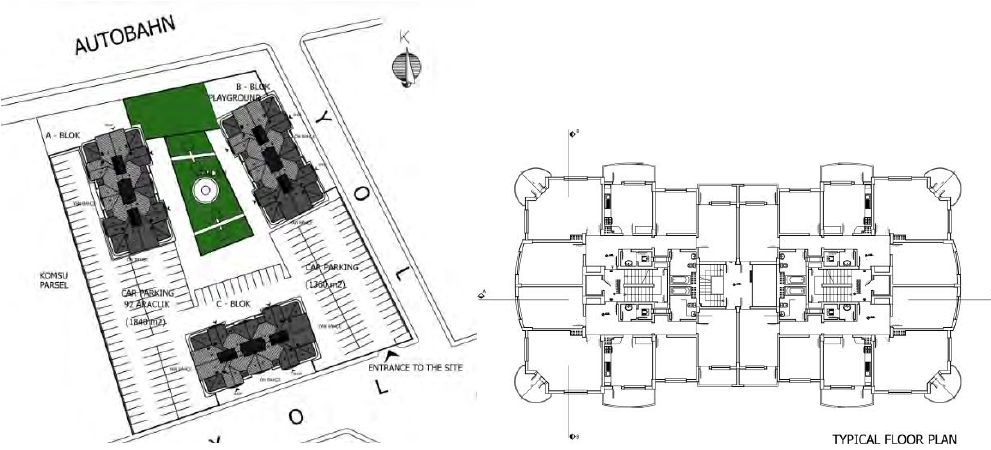
Figure 1: Site plan and typical floor plan of Mavisehir Housing